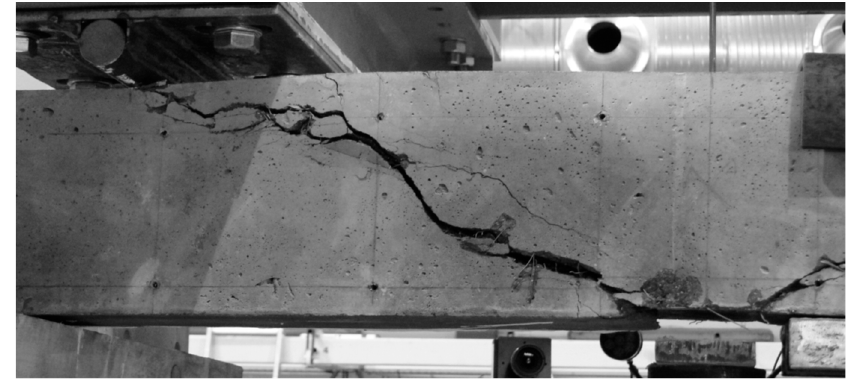
Figure 17. Example of a shear tension failure in the shear area of BF series beams.